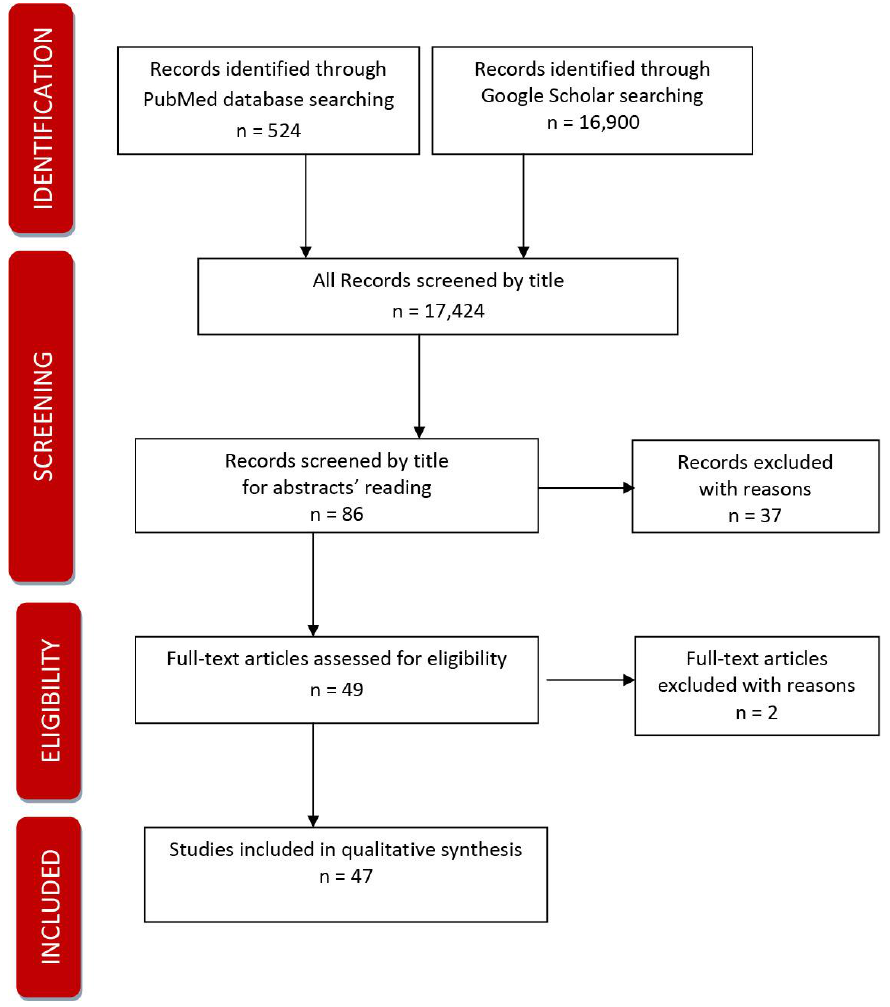
Figure 1. PRISMA diagram.